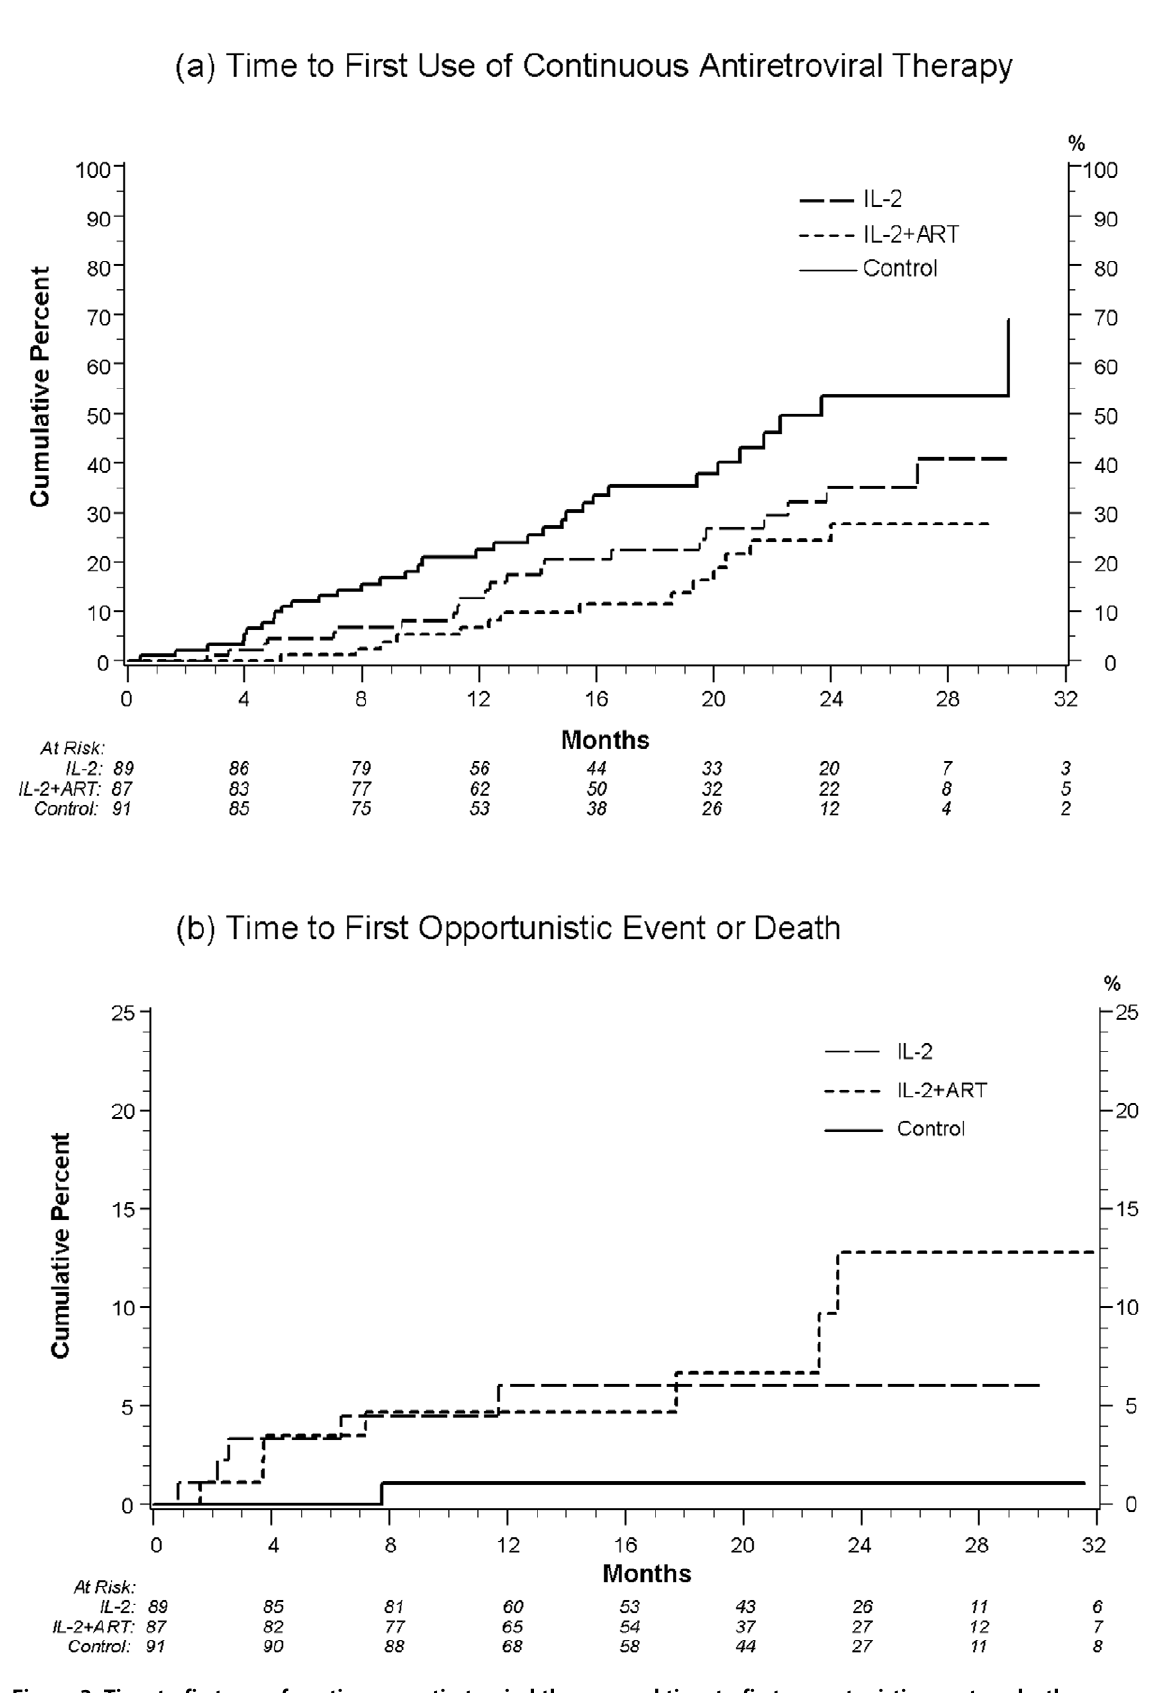
Figure 3. Time to first use of continuous antiretroviral therapy and time to first opportunistic event or death.